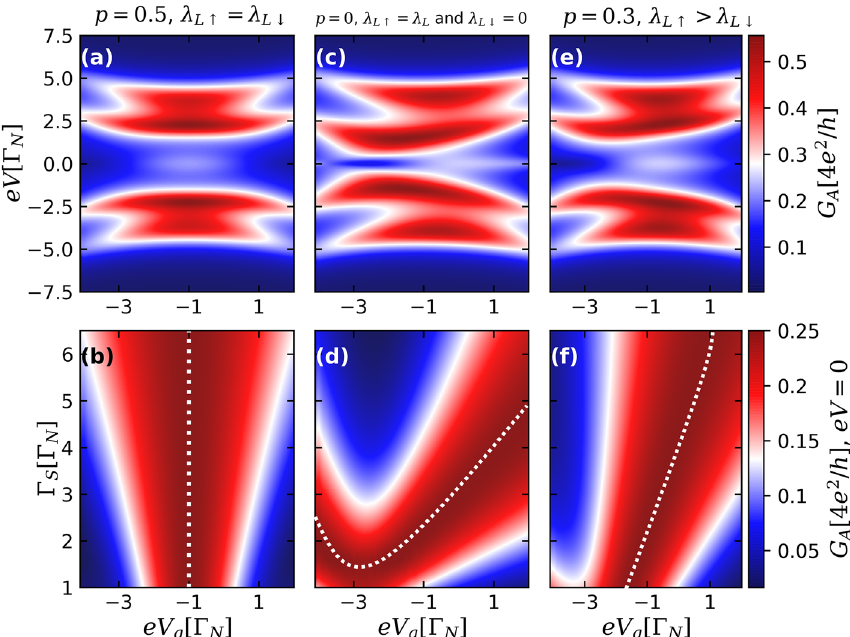
Figure 2. Upper panels: Color scale plots of the Andreev conductance G A [Eq. (5)] as a function of bias voltage 0 ), 0 ) and highly nonlocal MBSs ( (cid:31) eV and QD gate voltage eV g , for the case of nonoverlapping ( ε M R σ = = 3.0 Ŵ corresponding to ideal topologically protected situation, with Ŵ S N . Panels ( a , c , e ) correspond to the cases = (cid:31) (cid:31) (cid:31) 0.5 , (cid:31) 0 , (cid:31) 0 ) and intermediate of spin-independent ( p ), fully spin-polarized ( p L L L L and L = = ↑ = ↓ ↑ = ↓ = 0.3 , (cid:31) > (cid:31) L ( p ) QD-TSC couplings, respectively. Lower panels: Color scale plots of Andreev conductance L = ↑ ↓ at zero-bias as a function of the QD-S hybridization strength Ŵ S and eV g for same values of the parameter p as in the upper panels. White dotted lines correspond to isoconductance lines, defined by the condition that the 0 ) e 2 / h conductance reaches its maximal value, G A ( eV = =